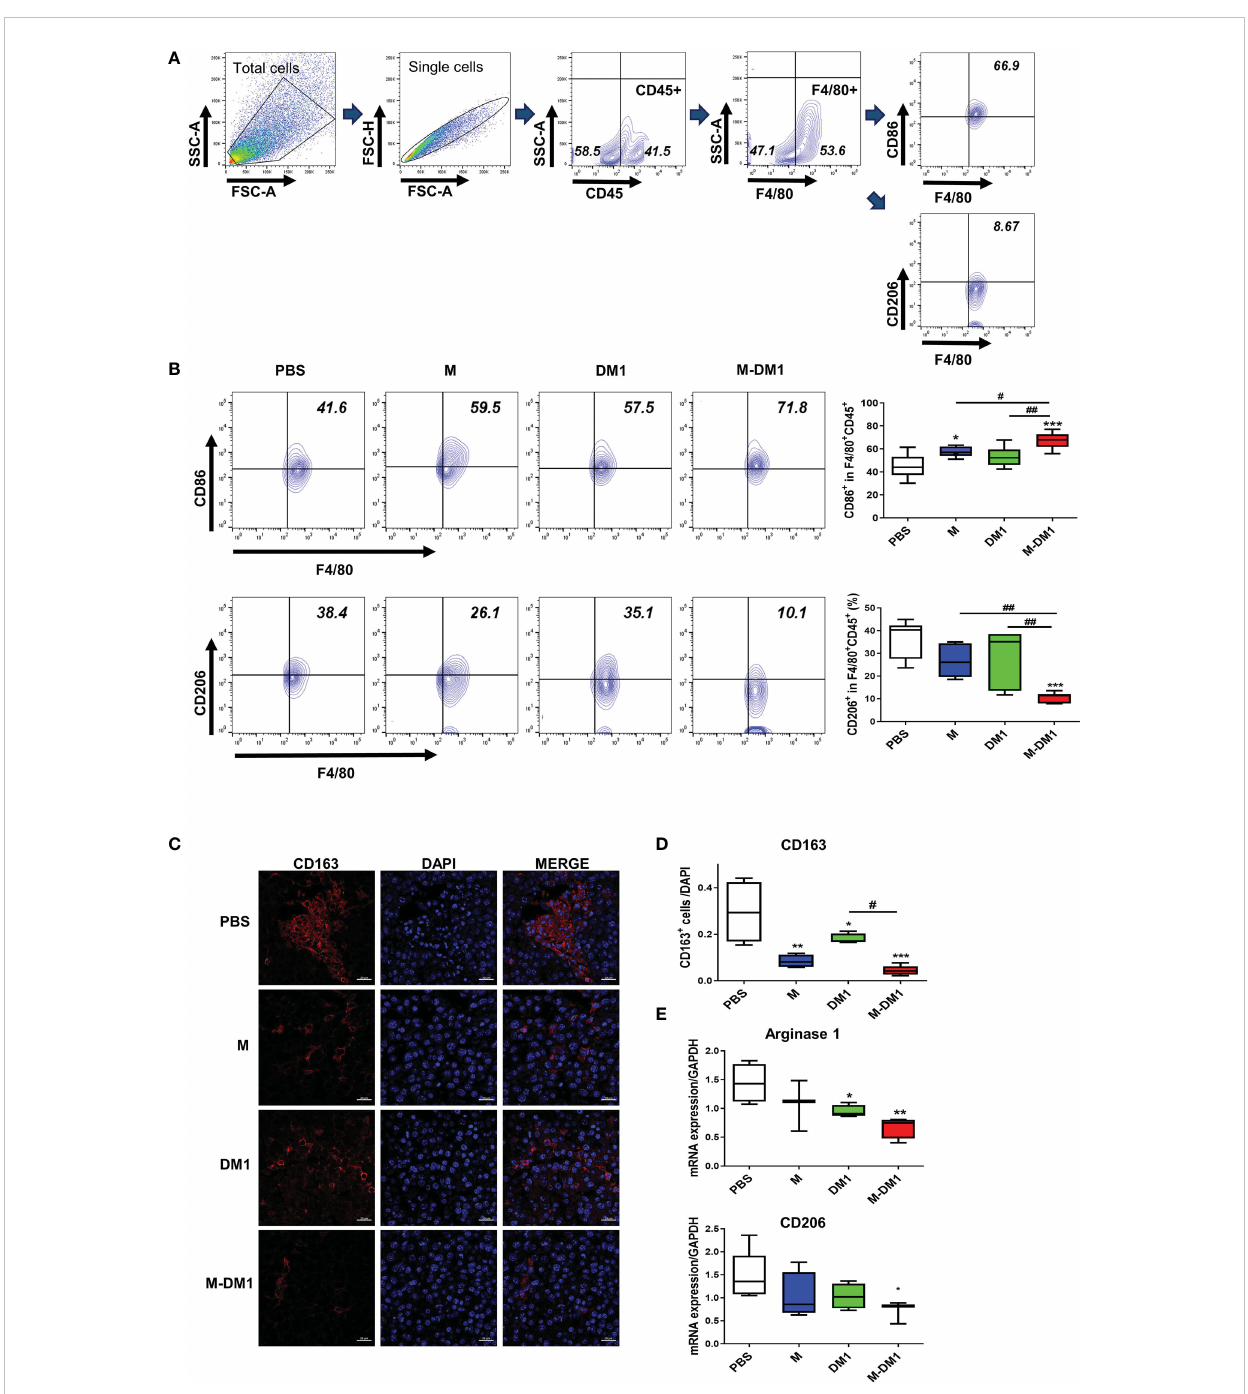
FIGURE 6 M-DM1 downregulates the population of M2 macrophages in melanoma tissues. After the in vivo test, the mice were sacri fi ced and the tumor tissue was harvested. (A) Macrophages from tumor-bearing mice were stained for pan macrophages (F4/80) and CD45 + cells. (B) The expression of CD86 (M1 macrophage, upper panel) and CD206 (M2 macrophage, bottom panel) was analyzed by fl ow cytometry ( n = 7). (C) The expression of CD163 in tumor tissues was determined by immuno fl uorescence staining. Tissue slides were stained for CD163 (red) and nucleus (DAPI; blue) (scale bar = 20 m m). (D) The graph represents CD163- positive cells relative to the number of nuclei. (E) The expression of arginase 1 and CD206 mRNA in tumor tissues was analyzed by real-time PCR ( n = 5). All data are presented as the mean ± SD. One-way ANOVA followed by Tukey ’ s post-hoc test was performed for group comparisons; *p < 0.05, **p < 0.01, ***p < 0.001 vs PBS group; #p< 0.05, ## p < 0.01 vs M or DM1